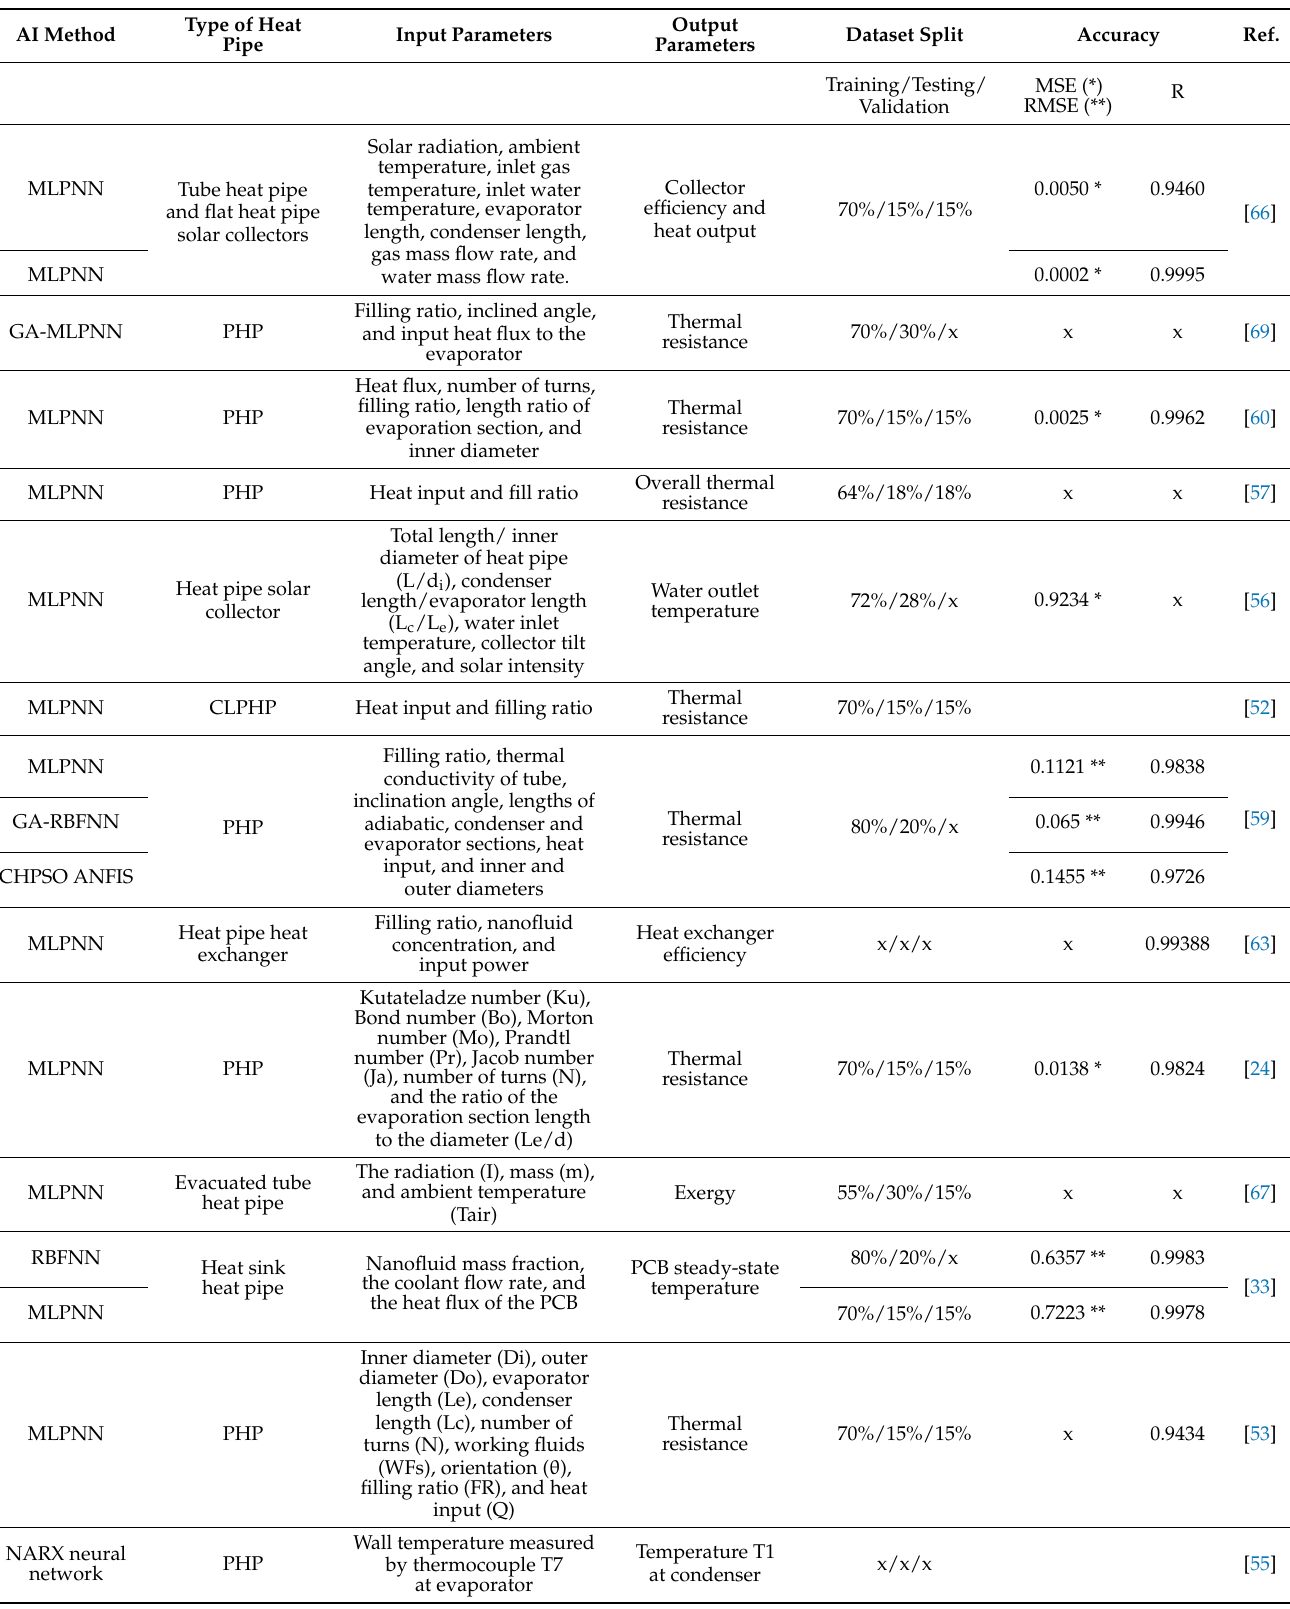
Table 3. Different AI models for predicting heat pipe thermal performance (*: MSE value, **: RMSE value, x: Accuracy measure not